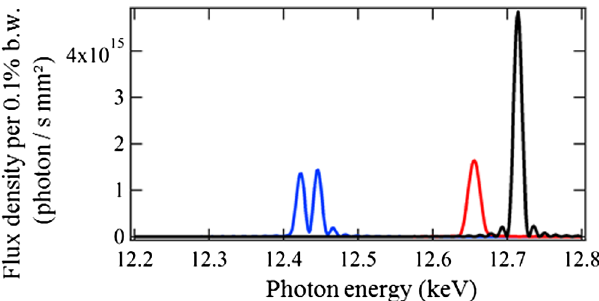
FIG. 9. Reconstruction of the photon beam size at the dia- phragm of the PX2 beam line, corresponding to the U20 undulator emission, for round electron beam configuration (see Table II), taking into account the modified electron trajectories in the presence of the 10 T solenoid field (a) and without solenoid field effect (b). The photon energy is 12.7